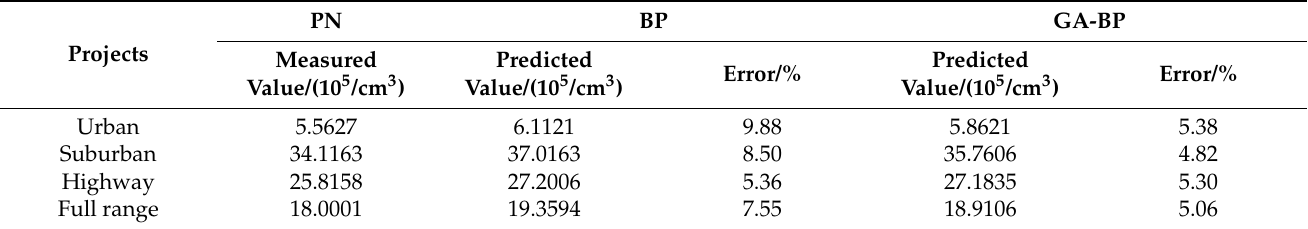
Table 7. Comparison of PN prediction results under BP and GA-BP